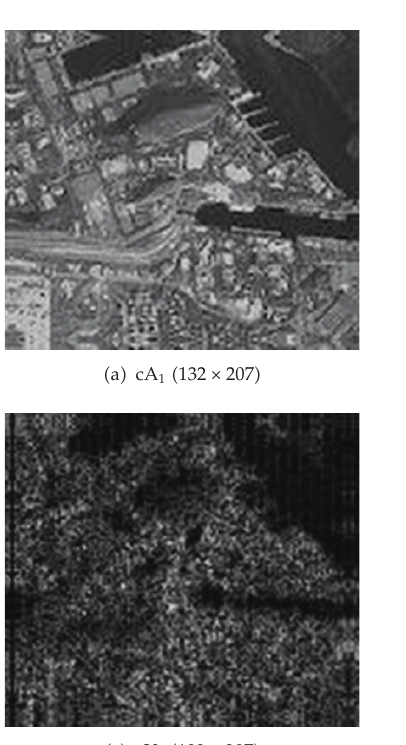
is used as a starting point as shown in Figure 5 (cid:3) a (cid:4) . The Sobel operator (cid:3) Sobel